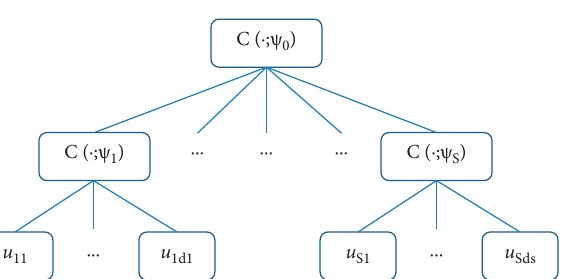
Figure 1: Hierarchical structure of ( d )-dimension nested copula